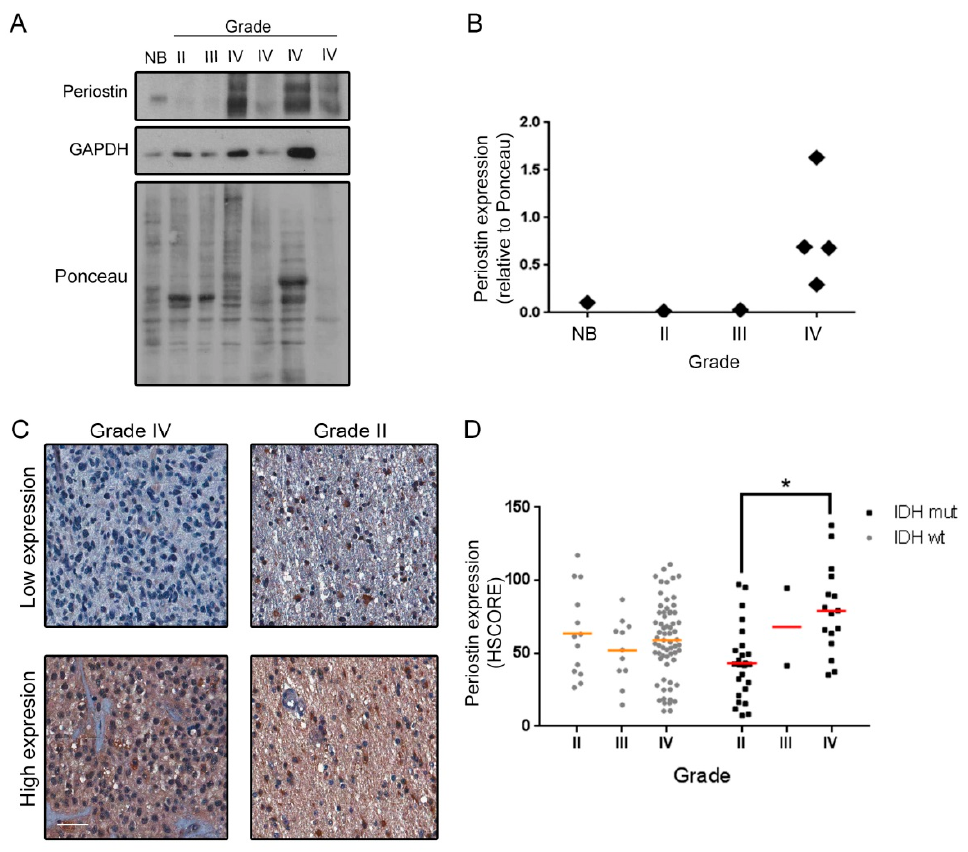
Figure 7. Periostin expression increases in GBMs. ( A ) Seven samples of gliomas of different grades were lysed and Periostin expression was analyzed by Western Blot. ( B ) Quantification of western blots was performed by Image J software. ( C ) Periostin expression was also evaluated by IHC in a TMA containing 138 glioma cases. ( D ) Automated quantification was performed and graph shows Periostin expression in gliomas of different grades (II, III and IV) and IDH1 status (IDH1 wild ‐ type— IDHwt; R132H mutant IDH1— IDHmut). Scale Bar— 50 μ m. * p = 0.004, One Way ANOVA followed by Tukey’s t test.